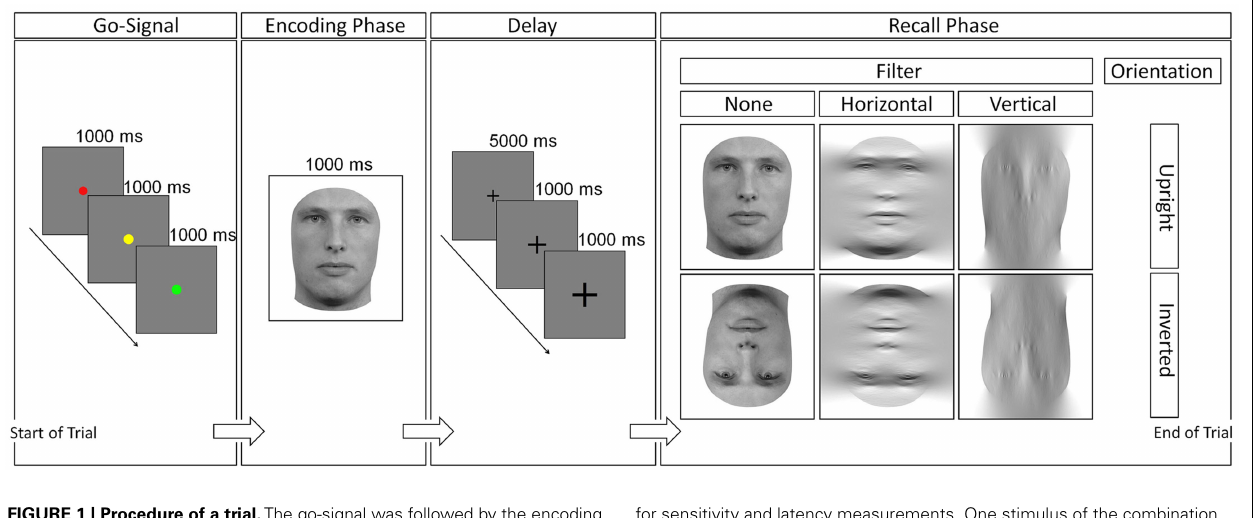
for sensitivity and latency measurements. One stimulus of the combination upright/inverted (orientation), and unfiltered/horizontally/vertically (filter) was presented in the